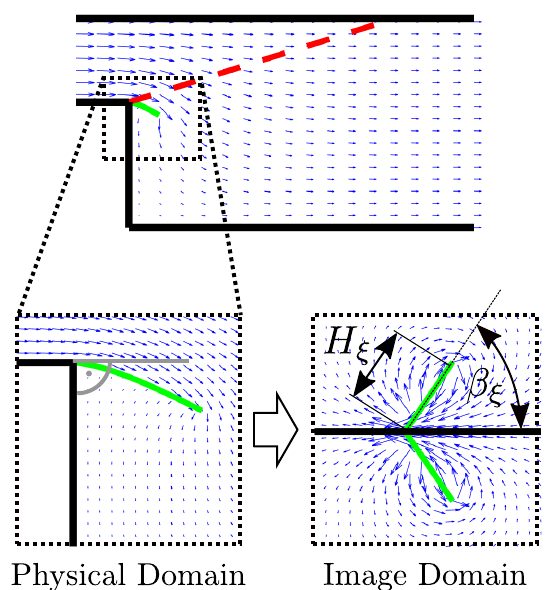
Figure 4. Flow field in a combustor with C r = 0.4 resulting from a source at ξ = 0 and a Kutta panel (green). Close up views of the Kutta panel H ξ = 2.1 and β ξ = π /3 are shown in the physical (bottom left) and the image domain (bottom